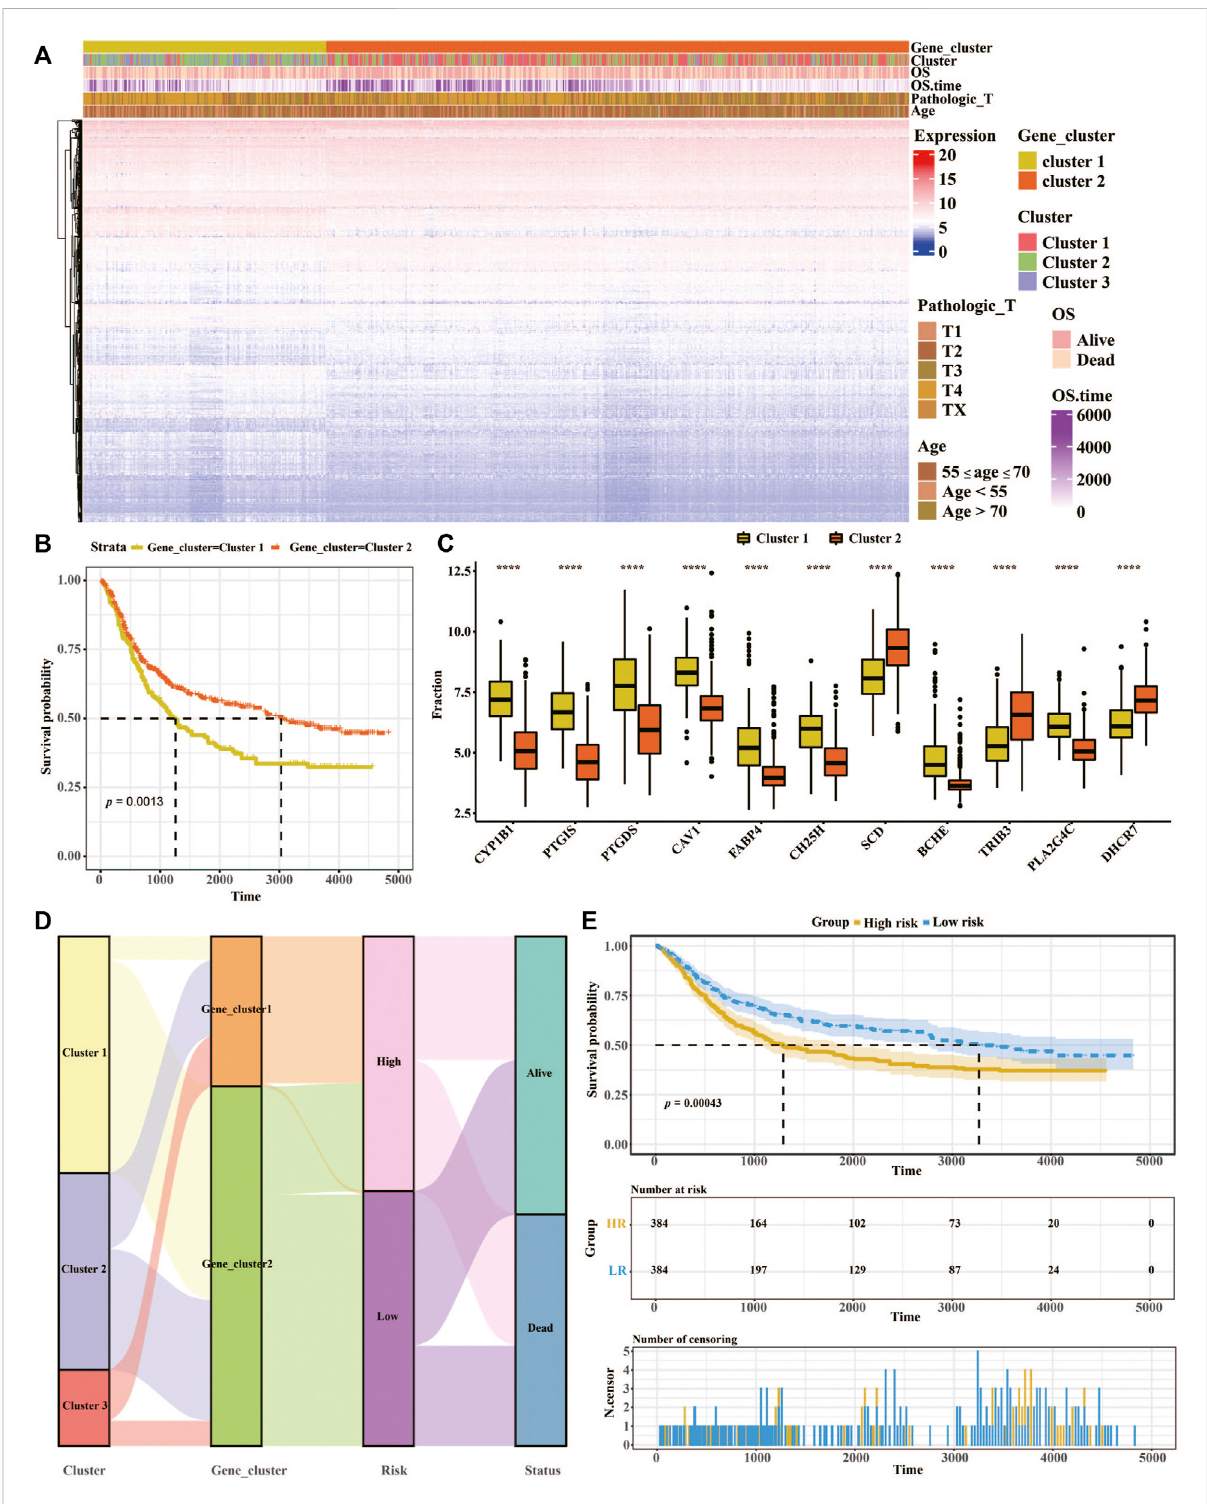
FIGURE 2 Constructing the prognostic model of the LMscore based on lipid metabolism signatures in GC. (A) Heatmap of unsupervised analysis and hierarchical clustering of the 3,104 DEGs and their associations with clinicopathological characteristics. (B) Kaplan-Meier plots for the association betweenlipidmetabolismgeneclustersandOSof768patientsintheTCGAandGEOdatasets.Andthelog-ranktestshowsanoverall p =0.0013. (C) The fraction of 11 differentially expressed genes in two lipid metabolism gene clusters. (D) Alluvial diagram showing the correlation of lipid metabolism subtypes with LMscore groups and clinical outcomes. (E) Kaplan-Meier curves of high- and low-LM score groups in the entire TCGA cohort. Log-rank test shows an overall p = 0.00043. *, p ≤ 0.05; **, p ≤ 0.01; ***, p ≤ 0.001; ****, p ≤ 0.0001, p ≤